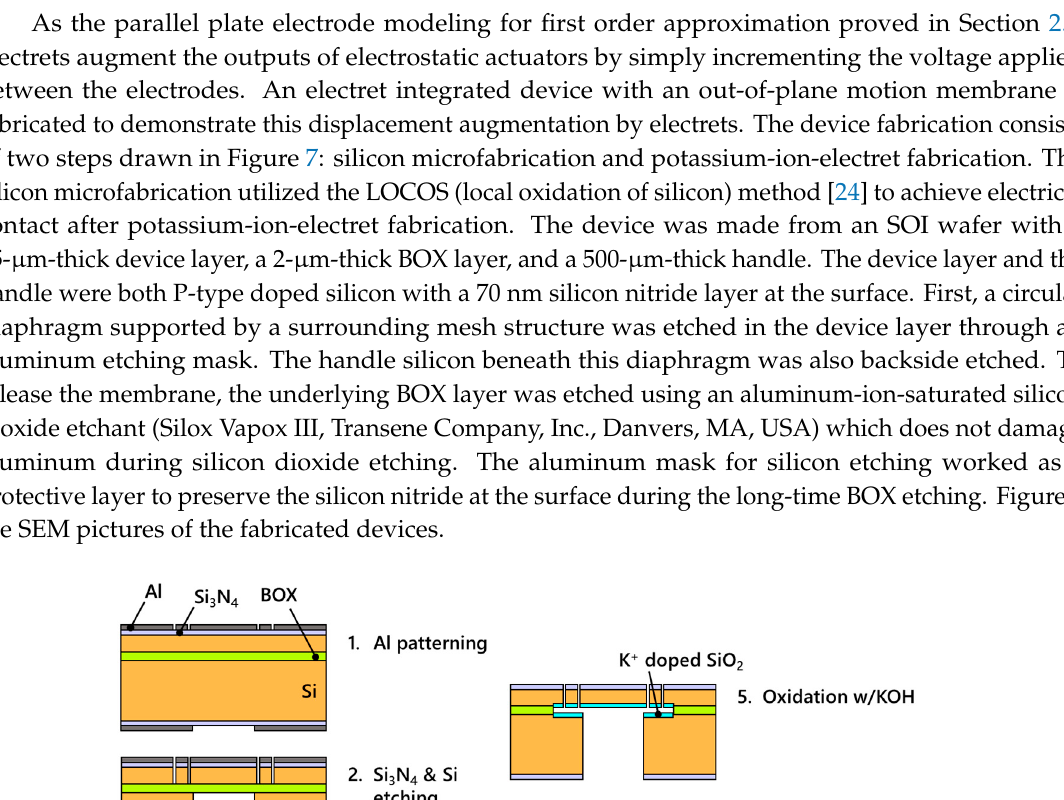
( b ) Figure 8. SEM pictures of fabricated out-of-plane membrane actuators: ( a ) individual chip; ( b ) chips on fabricated wafer. 3.2. Electromechanical Measurements An out-of-plane membrane actuator with a membrane diameter of (cid:2038) = 1.5 mm was fabricated to verify the displacement augmentation of electret integrated actuators. During the electret fabrication process in Section 3.1, a −50 V bias was applied for the oxide polarization. Electromechanical features of this device were characterized with the measurement setup shown in Figure 9. The displacement of the membrane was measured with a laser doppler vibrometer (MLD- 103, NEOARK, Tokyo, Japan) while supplying voltage from a function generator (33500B, Agilent, Santa Clara, CA, USA) for static characteristics, and a servo analyzer (DS-3200, Onosokki, Yokohama, Japan) for dynamic characteristics. Figure 10 shows voltage-displacement characteristics of the device before and after electret fabrication. After electret fabrication, the overall graph shifted by −40 V from the original point. Since voltage was applied to the counterpart electrode of the negatively charged electret, this indicates that the applied voltage cancelled the electret potential at −40 V and consequently the displacement became zero. Compared to the parallel plate electrode model in Section 2.2, a distinct pull-in was not observed since the actuation parts of the actual device are at both ends of a double-clamped beam. Furthermore, frequency characteristics of the device are shown in Figure 11. External DC bias voltages ranging between (cid:1848) (cid:3029)(cid:3036)(cid:3028)(cid:3046) = 0~ − 50 V were applied to the counterpart electrode of the negatively charged electret with an AC driving voltage of (cid:1848) (cid:3036)(cid:3041) = 20 V (cid:2926)(cid:2926) . Figure 11a shows results of